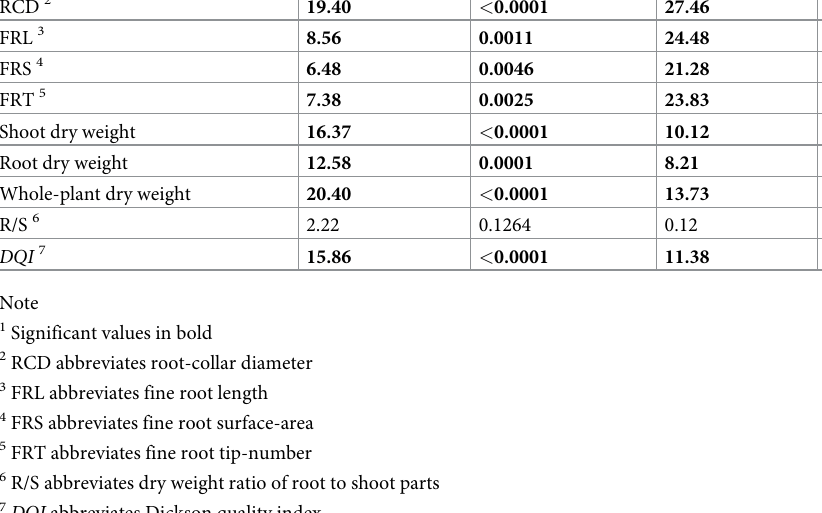
Fine root morphology None of the fine root parameters showed significant response to the combined spectral and Cos treatments (Table 2). However, both main effects of spectral condition and Cos spraying were significant for all three assessed fine root parameters (Fig 3). The spectrum of red-color light resulted in longer fine roots (624.43 ± 222.83 cm) compared to the green-light spectrum (328.22 ± 161.06 cm), but both were not statistically different compared to the blue-light spec- trum (504.47 ± 211.82 cm) (Fig 3A). Fine root surface was also larger in the red-light spectrum (249.42 ± 94.04 cm 2 ) compared to that in the green-light spectrum (133.08 ± 70.63 cm 2 ) with no difference from that in the blue-light spectrum (195.64 ± 95.07 cm 2 ) (Fig 3C). Root tip-number was lower in the green-light spectrum (825.58 ± 355.51 individuals) relative to that in the red- (1416.25 ± 492.20 individuals) and blue-light spectrums (1218.67 ± 445.97 individuals) (Fig 3E).